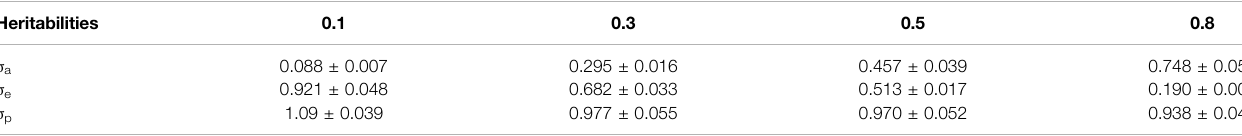
TABLE 2 | Genetic parameter estimation of the different heritabilities in generation G15.